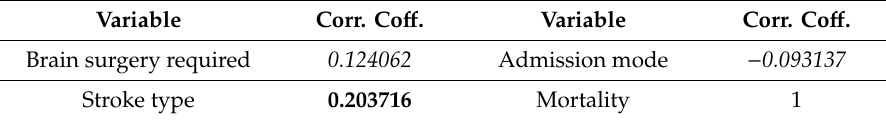
Table 5. Correlation coe ffi cients of the variables (over 0.09) among 11 variables. Variable Corr. Co ff